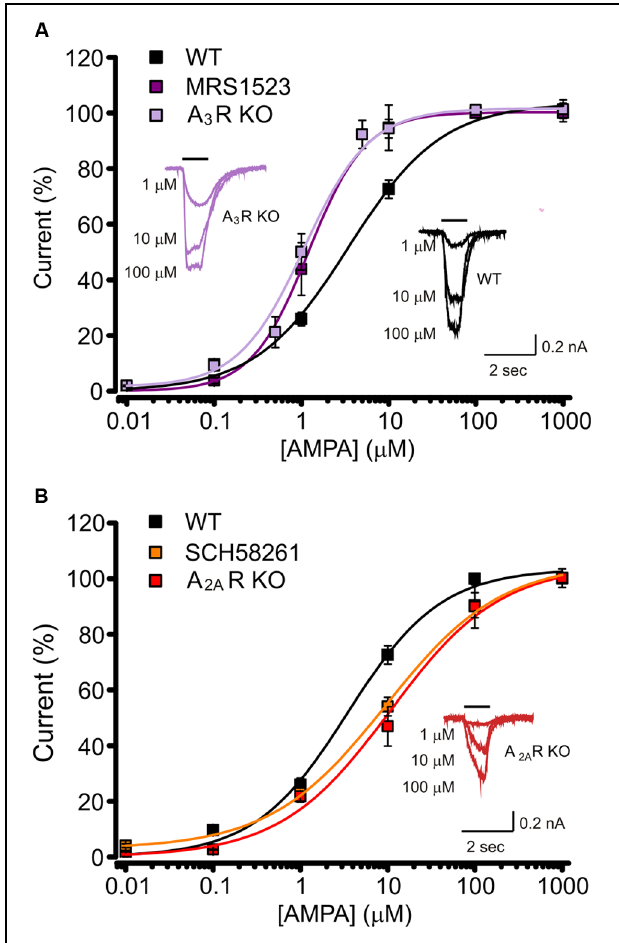
FIGURE 2 | Basal activation of AR subtypes changes the apparent affinity for AMPA. (A) AMPA dose response curves ( + CTZ 25 μ M) obtained in cultured hippocampal neurons in control (black, n = 32), in the presence of A 3 R antagonist MRS1523 (100 nM, n = 11, purple) and in neurons from A 3 R KO mice ( n = 11, magenta). Inserts: sample traces representing current responses to 1, 10, and 100 μ M AMPA ( + CTZ 25 μ M) in WT and A 3 R KO hippocampal neurons. (B) AMPA dose response curves ( + CTZ 25 μ M) obtained in cultured hippocampal neurons in the presence of A 2A R antagonist SCH58261 (30 nM, n = 9, orange) and in neurons from A 2A R KO mice ( n = 12; red; control condition in black). Inserts: representative current responses to 1, 10, and 100 μ M AMPA ( + CTZ 25 μ M) in A 2A R KO hippocampal